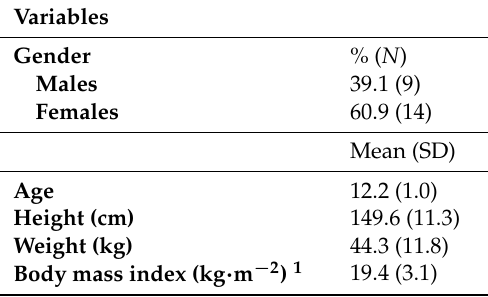
Table 1. Descriptive characteristics of the elementary students that participated in the experiment.